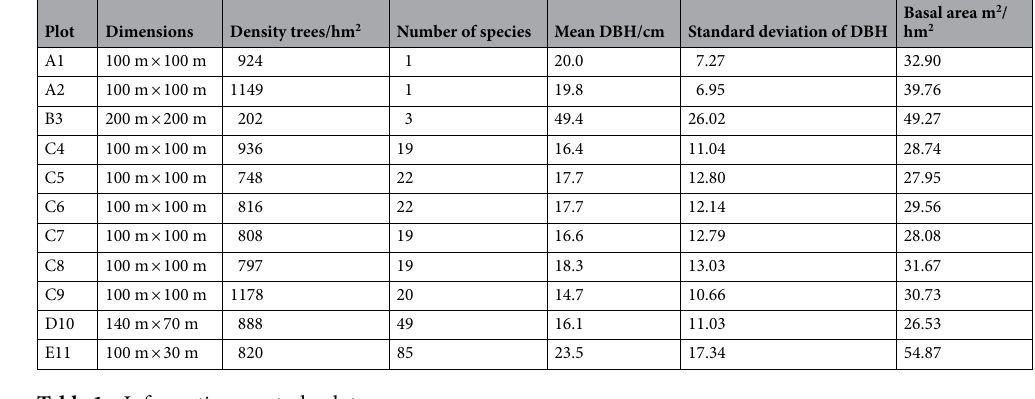
Table 1. Information on study